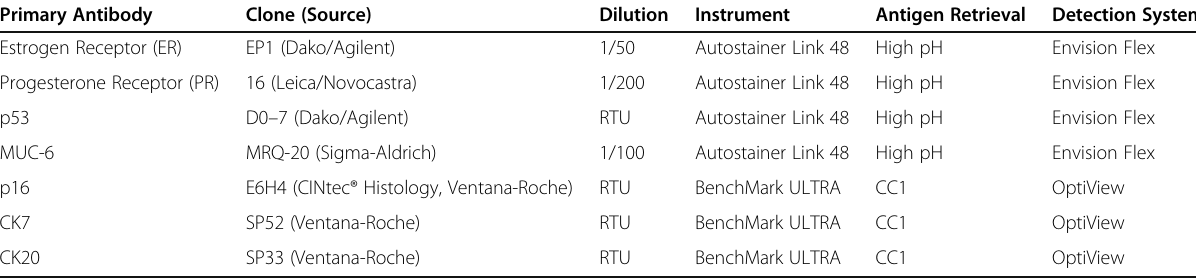
Table 1 Showing antibody clones, antibody dilutions and detection system Primary Antibody Clone (Source) Dilution Instrument Antigen Retrieval Detection System Estrogen Receptor (ER) EP1 (Dako/Agilent)